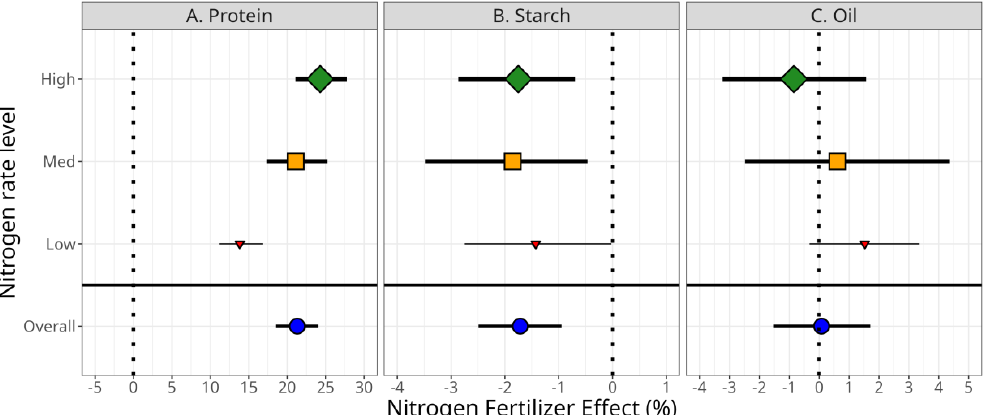
Figure 5. Summary of N fertilizer effect (%) on maize grain quality components (( A )—Protein, ( B )—Starch, and ( C )—Oil) pooled by the N fertilizer rate level (low ≤ 70 kg N ha − 1 , medium >70–150 kg N ha − 1 , and high >150 kg N ha − 1 ) vs. their respective control. Within each variable, symbols represent the mean effect per study, while size and whiskers represent their respective weights and uncertainties, respectively. Blue circles represent the overall random effects model with their respective